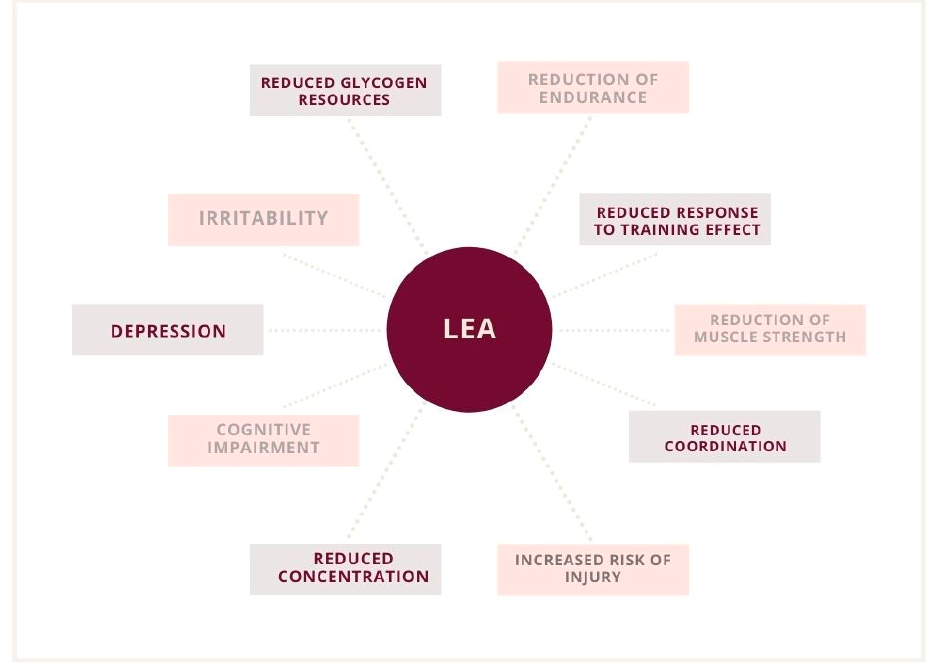
Figure 2. Psychological and physiological implications of low energy availability (LEA).